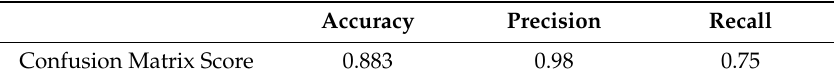
Table 1. Question retrieval performance accuracy.